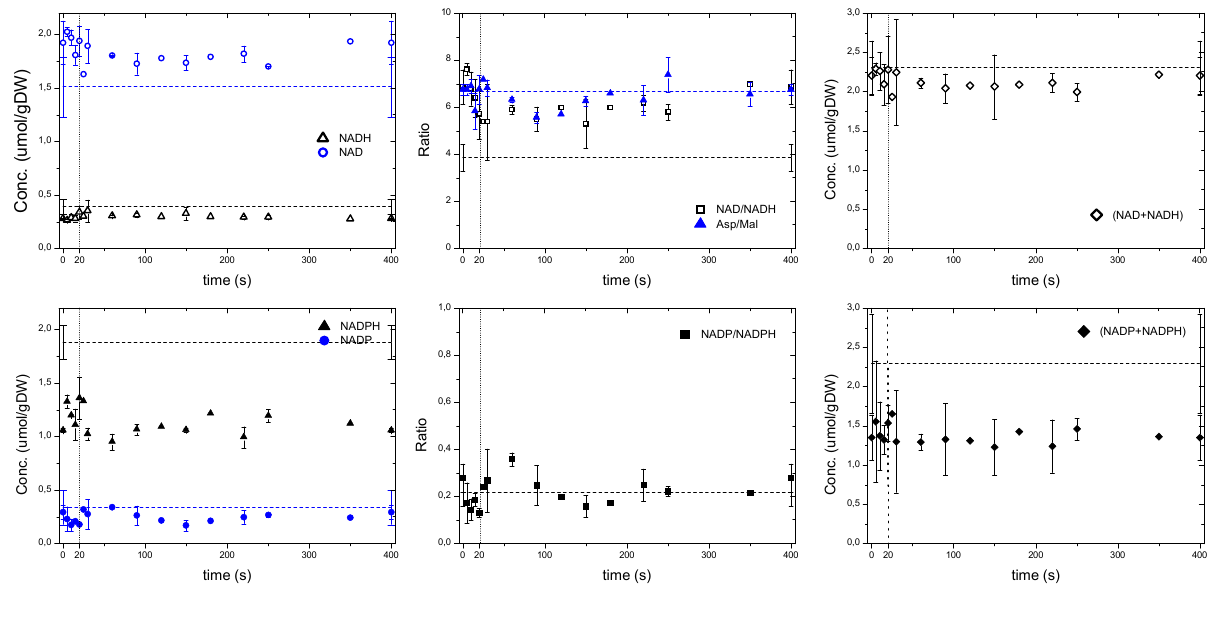
Figure 4. Whole cell measurements of NAD, NADH, NADP, NADPH as well as ratios based on sensor reactions. The dashed line represents the reference measurement during the chemostat phase (D = 0.1 h − 1 ), error bars represent the standard error of duplicate determination during two subsequent cycles. The vertical dotted line represents the end of the feeding